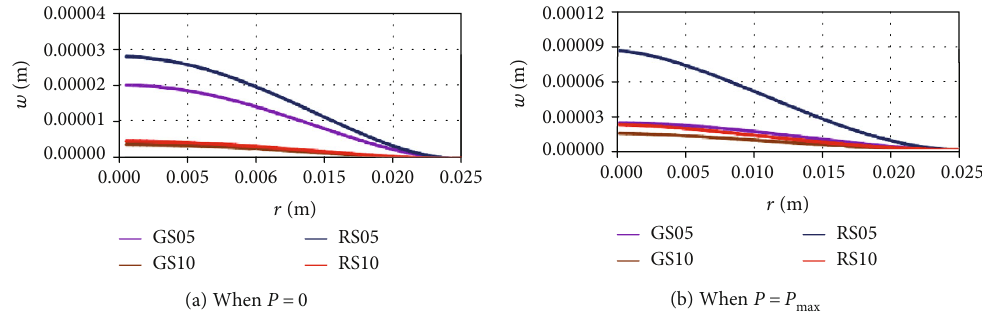
Figure 8: De fl ection distribution curves.